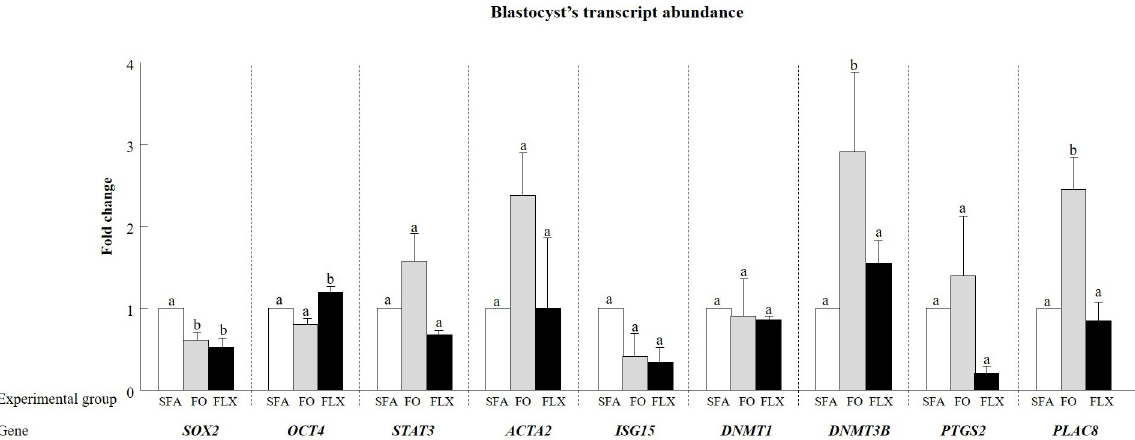
Fig 10. The effect of omega-3 sources flaxseed and fish oil on gene expression in embryos at the blastocyst stage. At 8 days post fertilization, the blastocysts developed from each experimental group: saturated fatty acid (SFA; control), fish oil (FO), and flaxseed oil (FLX), taken after the feeding trial, were collected, snap-frozen, and stored at -80˚C for RNA extraction and qPCR analysis (n = 4 blastocysts per sample; 4 replicates). Transcript levels of SOX2 , OCT4 , STAT3 , ACTA2 , ISG15 , DNMT1 , DNMT3B , PTGS2 , and PLAC8 were normalized against the geometric mean of YWHAZ and SDHA . Data are expressed relative to the SFA group. Data are presented as the means ± SEM. Different letters above the columns indicate significant differences relative to the control group (SFA) for each gene ( P < 0.05). https://doi.org/10.1371/journal.pone.0265650.g010 PLOS ONE | https://doi.org/10.1371/journal.pone.0265650 March 24,